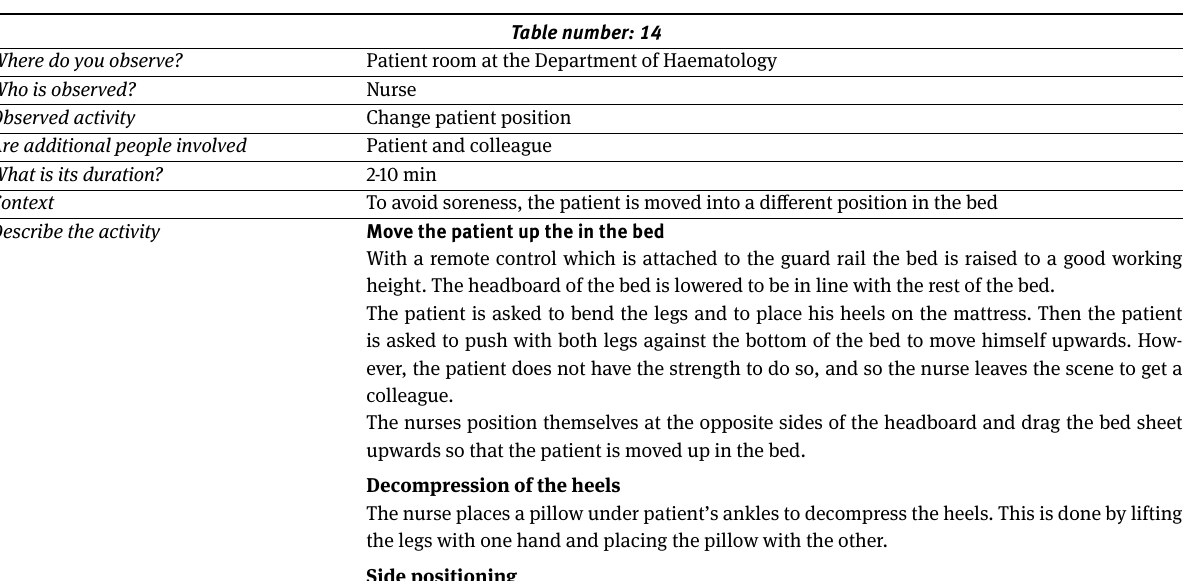
Table 2: Report number 14, table number 6 from evening observation at the Department of Hospital and Cleaning service. The correspond- ing categorization of this process is provided in Figure